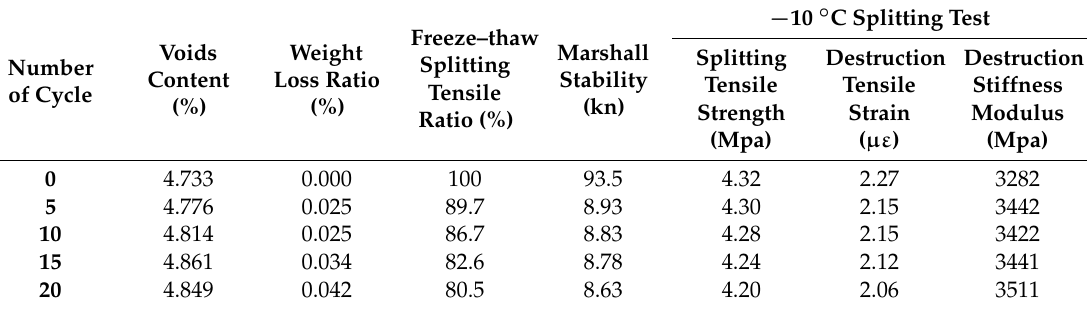
Table 7. Variation of NHSS-AC parameters under soak cycle.